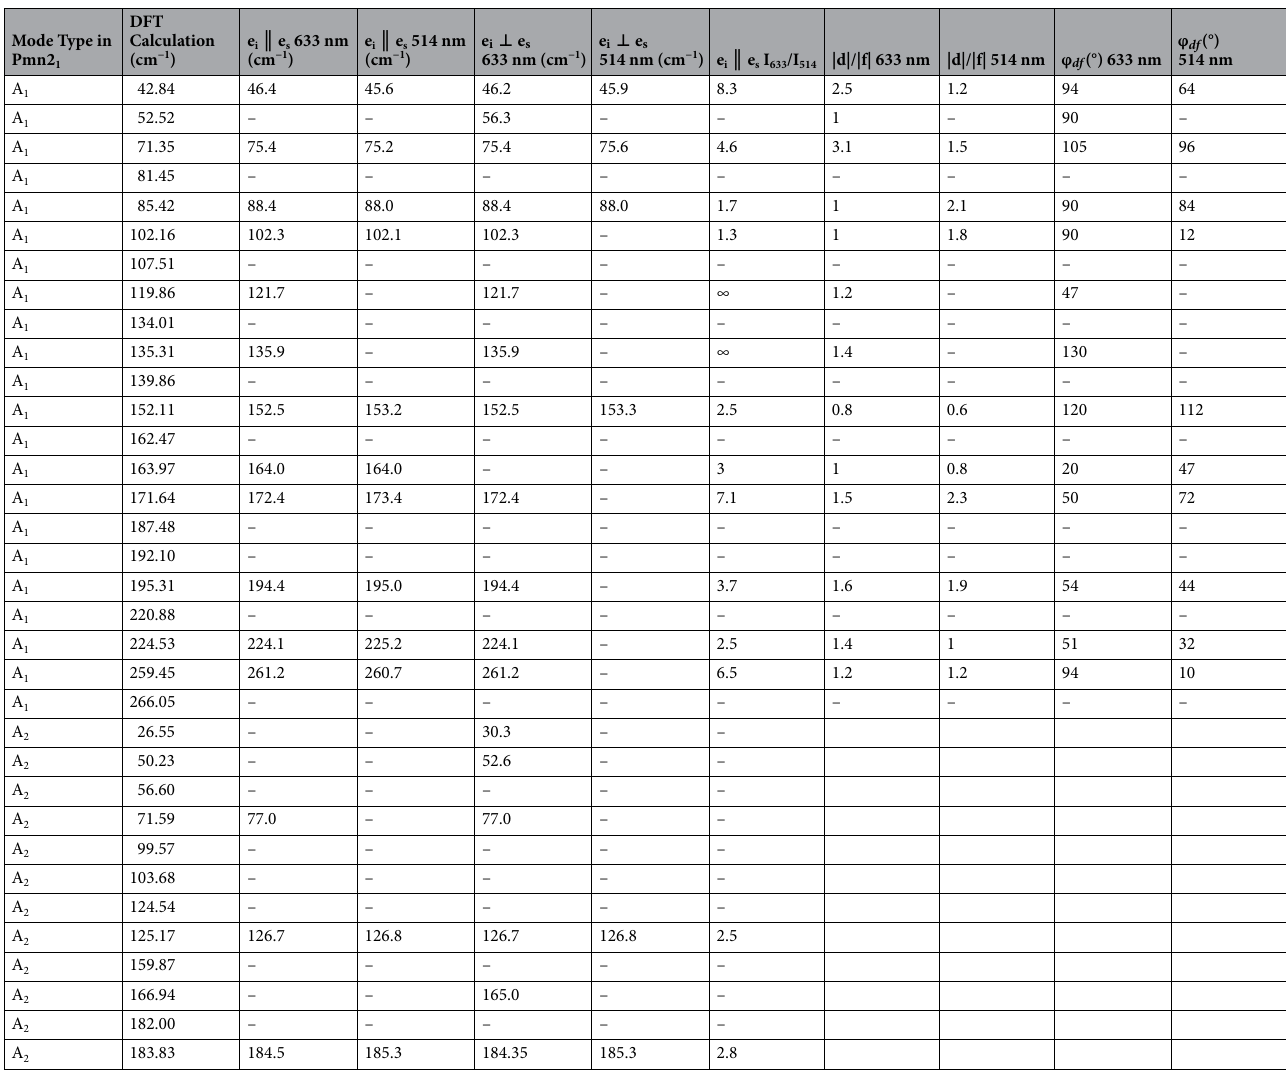
Table 1. Calculated A 1 and A 2 Raman modes of the NbIrTe 4 nano-flake by using density functional theory (DFT) and experimentally extracted values in parallel and cross configurations using 633 nm and 514 nm excitation. The last four columns express the parameters d/f and for each experimentally detected A 1